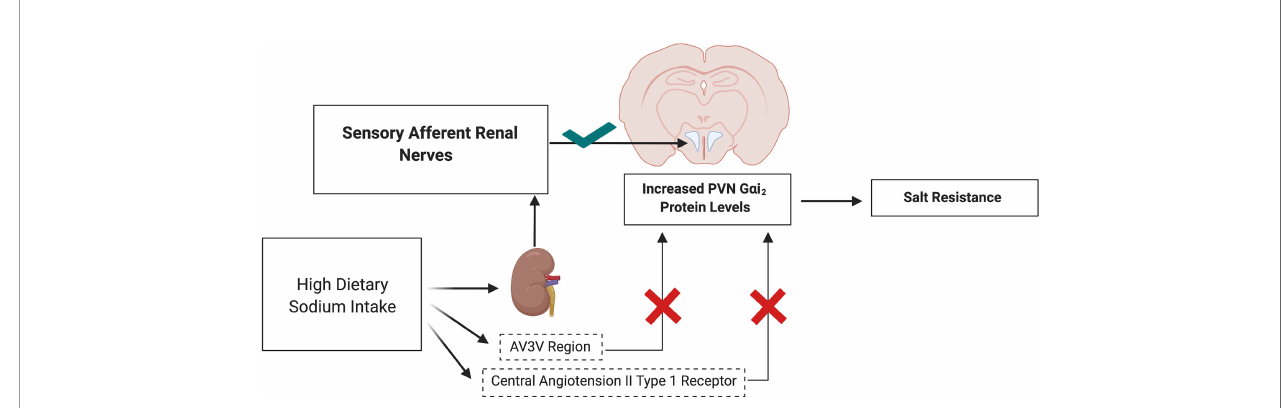
FIGURE 4 | Schematic representation of upregulation of PVN G a i 2 protein-dependent responses to elevated dietary sodium intake in salt resistance. Upregulation of PVN speci fi c G a i 2 is mediated by the peripheral sensory afferent renal nerves and does not depend on the AV3V sodium sensitive region or actions of central angiotensin II type 1 receptors. Image was generated using